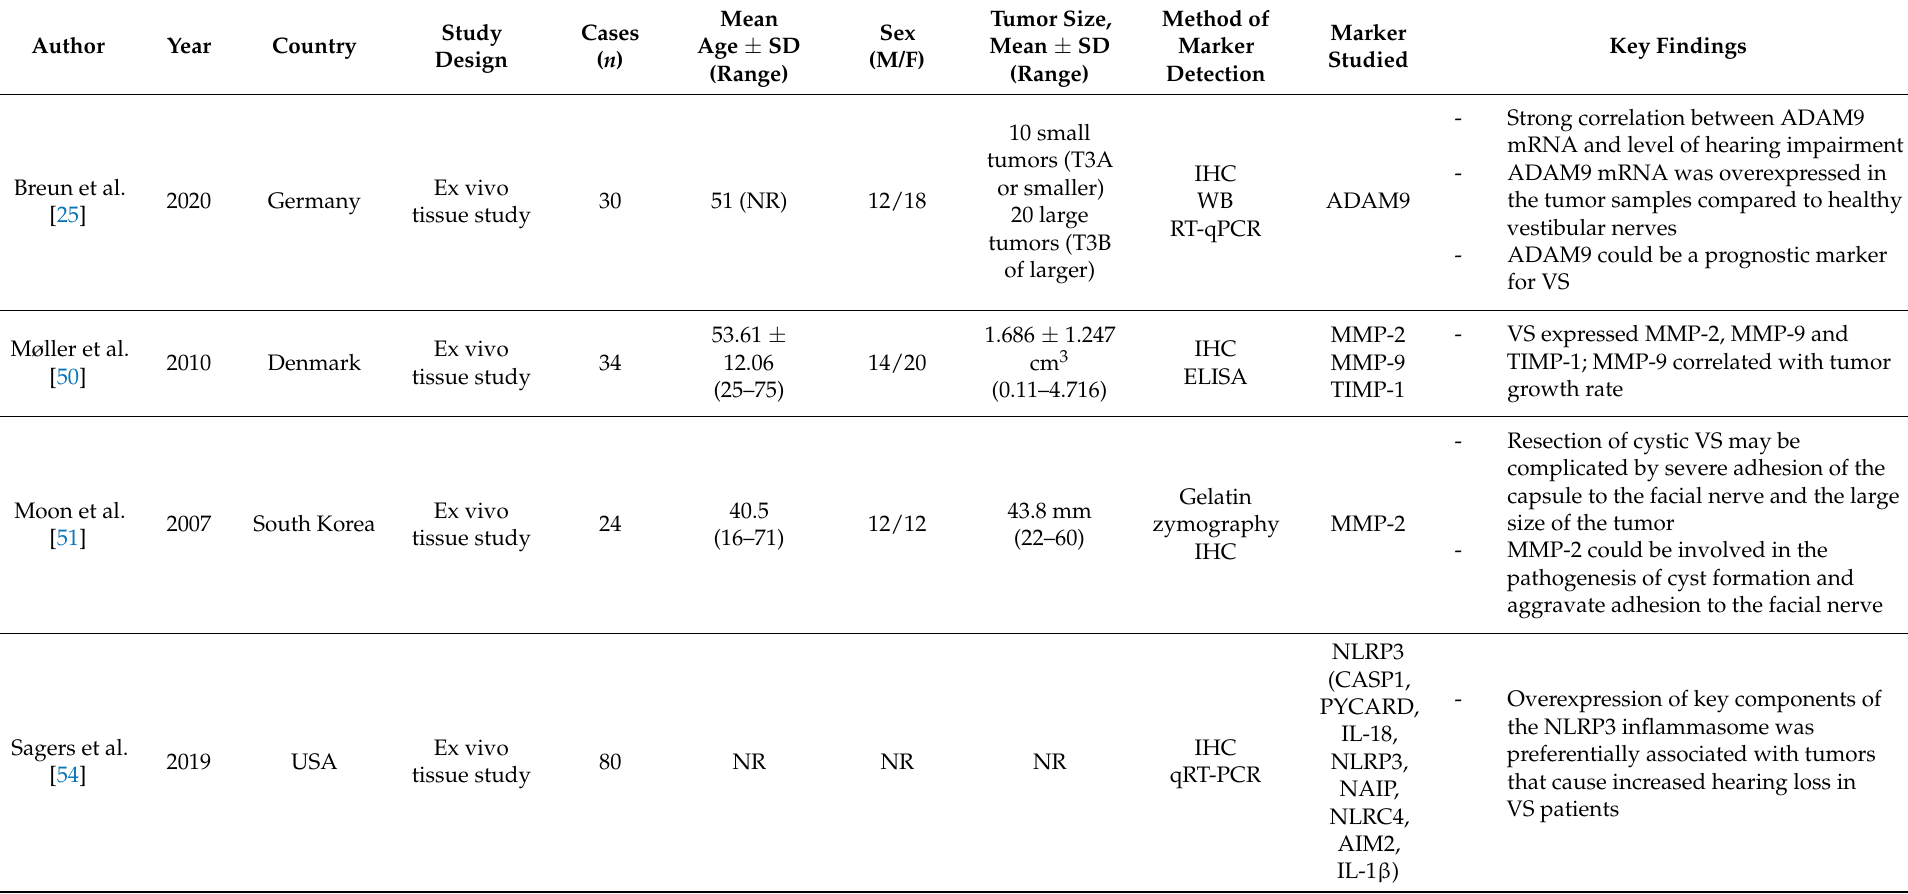
Table 5. Studies examining the role of local inflammation proteins in sporadic vestibular